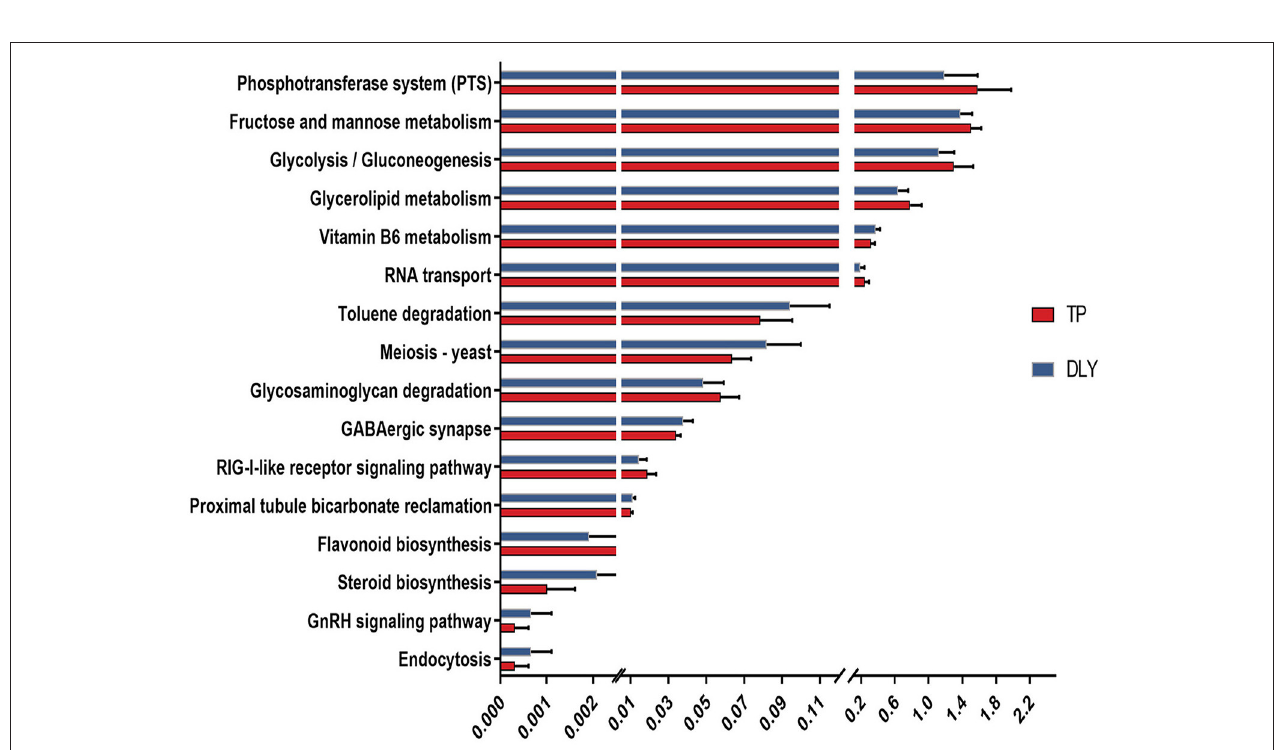
FIGURE 6 | Differential KEGG pathway analysis based on Tax4Fun functional